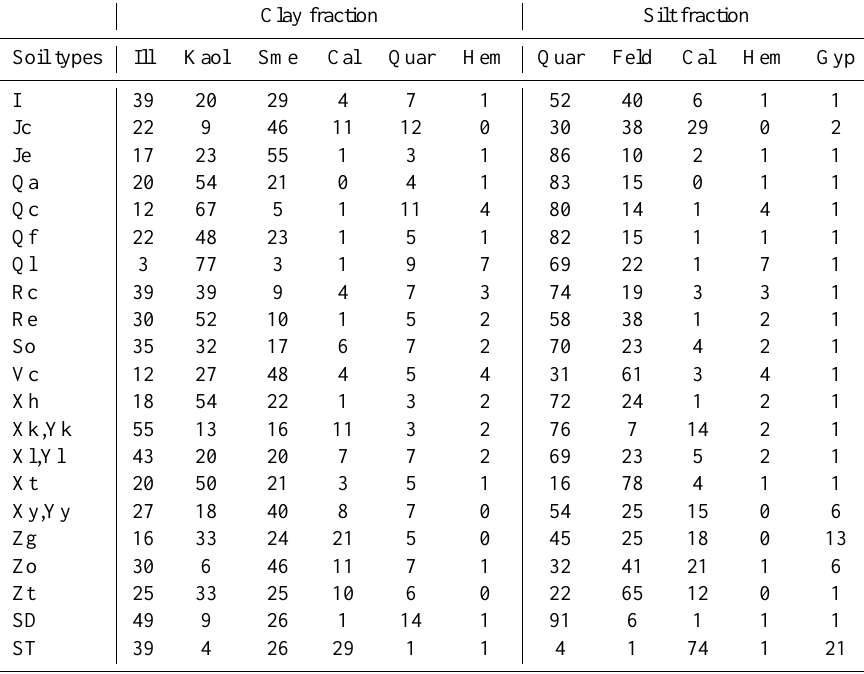
Table 1. Mean Mineralogical Table from Claquin et al. (1999). Gypsic Xerosols and Yermosols (Xy,Yy), Gleyic Solonchaks (Zg), Orthic Solonchaks (Zo) and salt flats (ST) are renormalized to 100. Hematite is added to the clay fraction by subtracting the mass from illite following Balkanski et al. (2007) and Nickovic et al. (2011). For the sensitivity study involved in only a clay fraction source of hematite, the minerals with silt-sized source fractions were equally scaled from the mass removed from hematite.